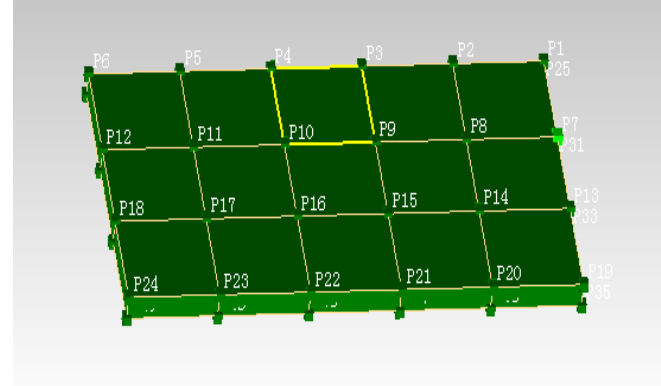
Figure 7. Testing point distribution for the slab plate.